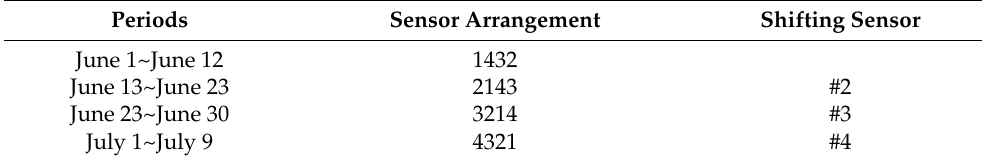
Table 1. Sensor arrangements in four different periods. Periods Sensor Arrangement Shifting Sensor June 1~June 12 1432